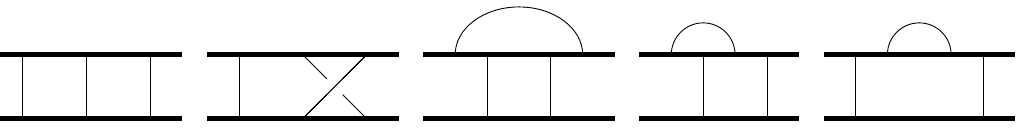
Figure 2 . Diagrams with cubic vertices relevant for classical O ( α 3 ) observables in scalar QED. The first two graphs appear in the conservative sector and the three “mushroom” graphs are only relevant for radiative effects. The diagrams split into different gauge-invariant subsectors. The III and IX graphs (corresponding to the first two diagrams) are proportional to q 3 mushroom graphs are proportional to q 2